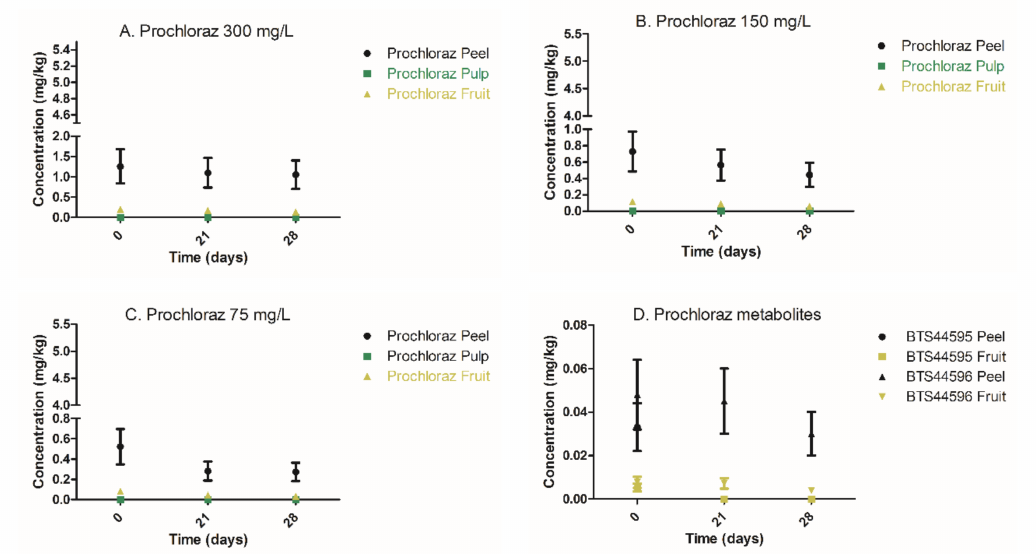
Figure 3. Depletion kinetics of prochloraz and its metabolites (BTS 44595 and BTS 44596) in Reed avocado peel, pulp, and whole fruit following spray application of prochloraz formulations containing 300, 150, and 75 mg / L active compound (Sportak ® ). ( A ) Prochloraz (300 mg / L) depletion in peel, pulp, and whole fruit. ( B ) Prochloraz (150 mg / L) depletion in peel, pulp, and whole fruit. ( C ) Prochloraz (75 mg / L) depletion in peel, pulp, and whole fruit. ( D ) Prochloraz metabolites depletion kinetics in peel and whole fruit, following immersion of Reed avocado in 300 mg / L prochloraz solution. In pulp, no residual levels of metabolites were